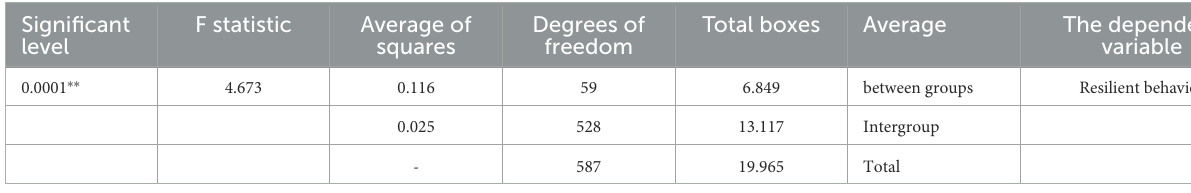
TABLE 9 Comparison of resilience index of pistachio farmers in rural areas of Rafsanjan and Anar cities against climate change. Significant level